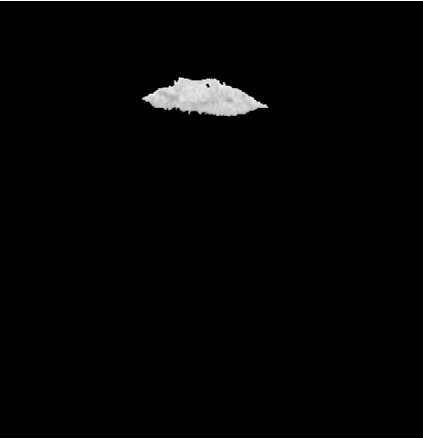
Figure 6. The result, after applying the region growing in Figure 5.